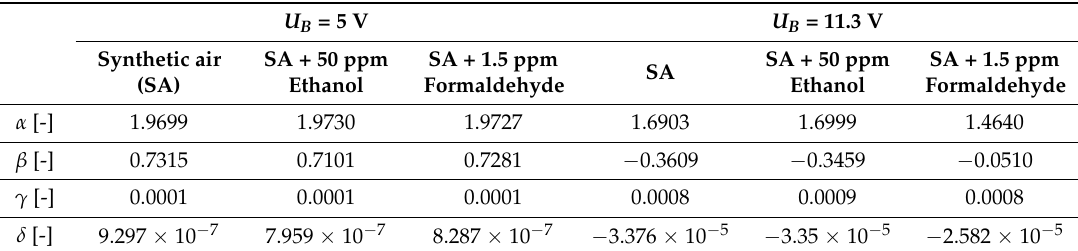
Table 3. Dimensionless stability index ( α ), skewness parameter ( β ), scale parameter ( γ ), and location parameter ( δ ) characterizing L é vy-stable distributions for voltage fluctuations across an AuNP-based gas sensor for the shown gases and bias voltages ( U B